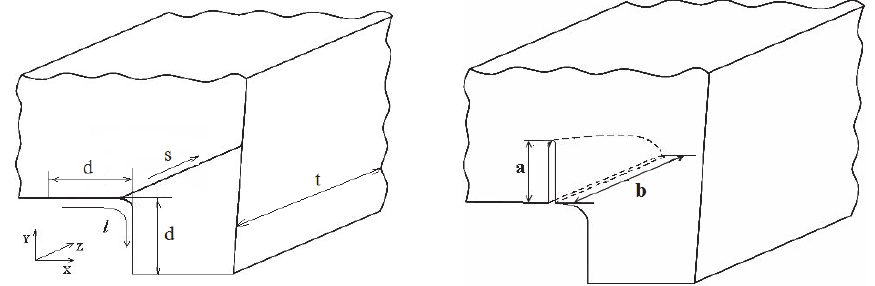
Figure 3: Coordinate systems at slot fillet.